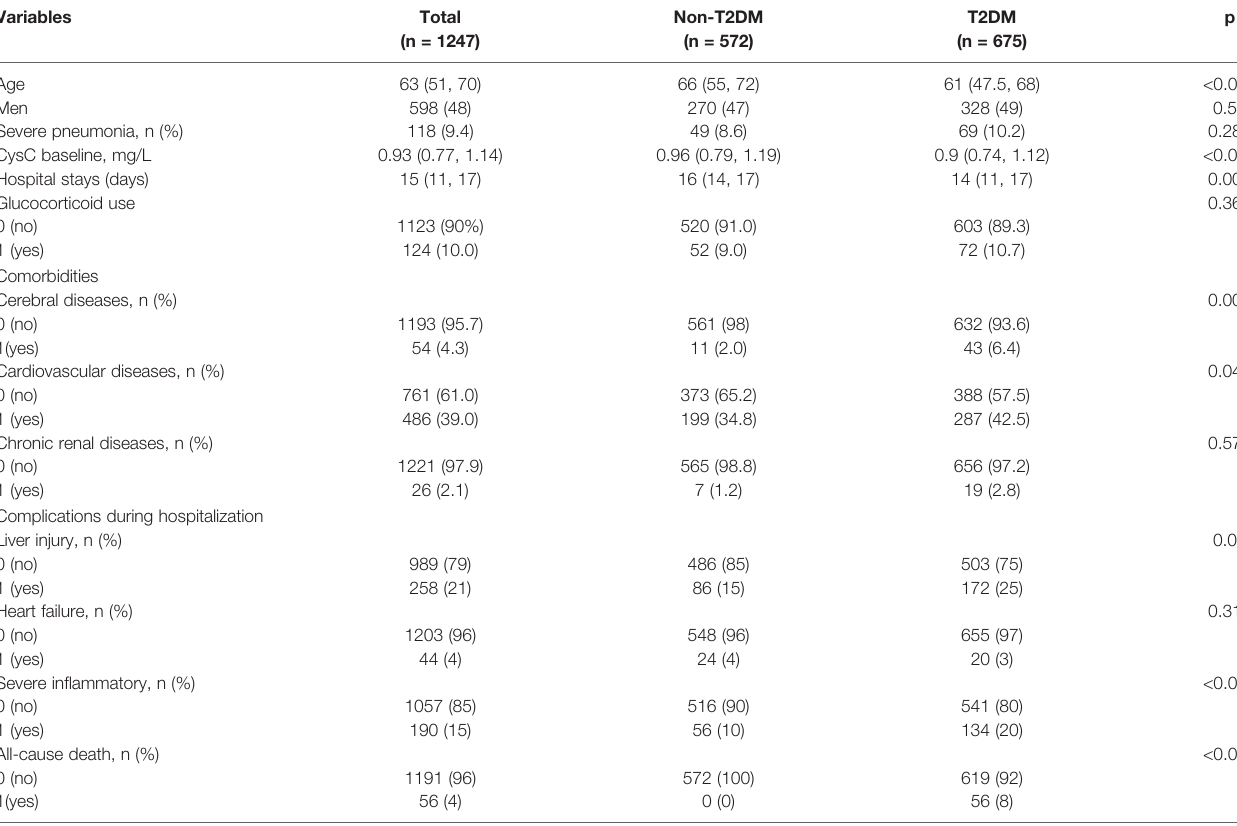
TABLE 1 | Characteristics of hospitalized patients with